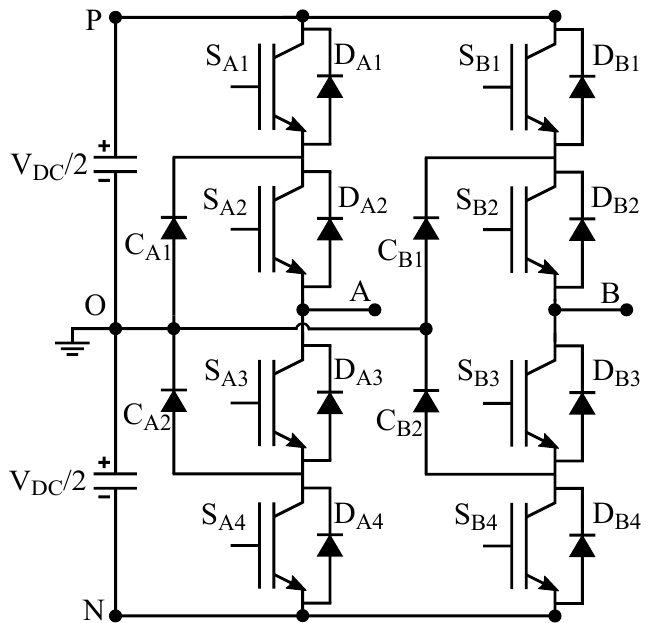
Figure 1. Single-phase neutral point clamped inverter.